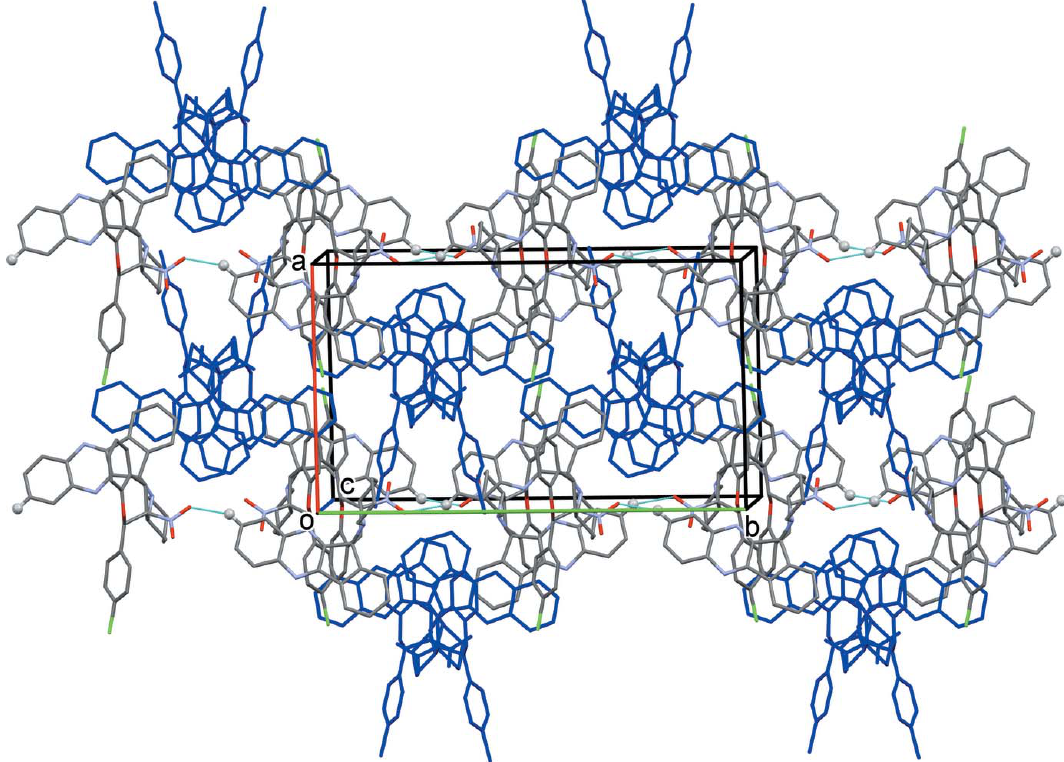
Figure 4 The crystal packing of the title compound viewed along the c axis. The interlinking of B molecules via C—H (cid:2)(cid:2)(cid:2) O hydrogen bonds (see Table 1 for details) generates chains running along the [010] direction. The A molecules are shown in blue and the hydrogen bonds are shown as dashed lines. For clarity, H atoms not involved in the various intermolecular interactions have been